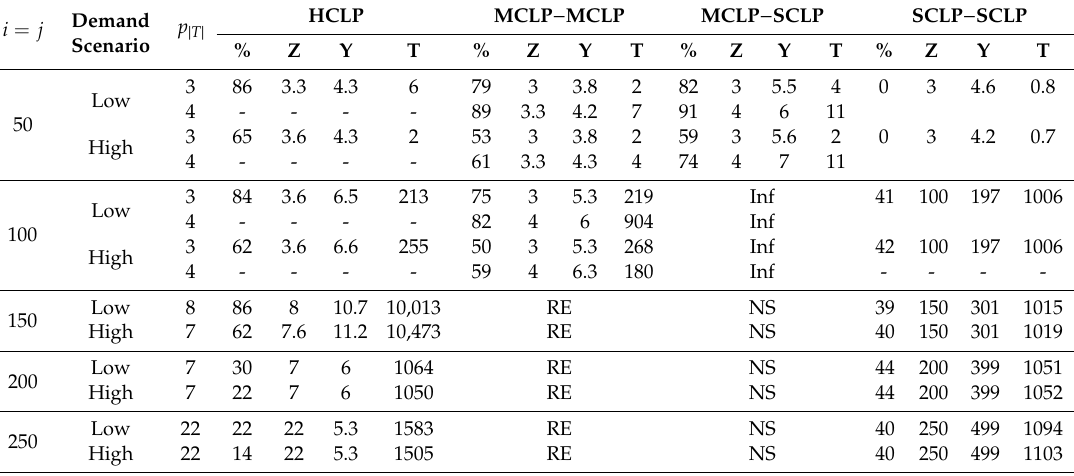
Table 6. Computational results to compare di ff erent variants for three regions. HCLP: hybrid covering location problem.